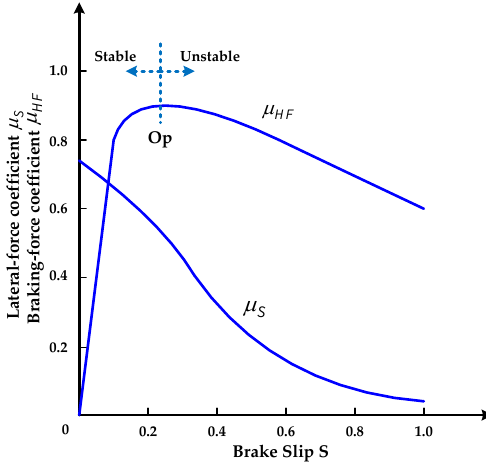
Figure 1. Relationship between tire adhesion coefficient and brake slip curve.